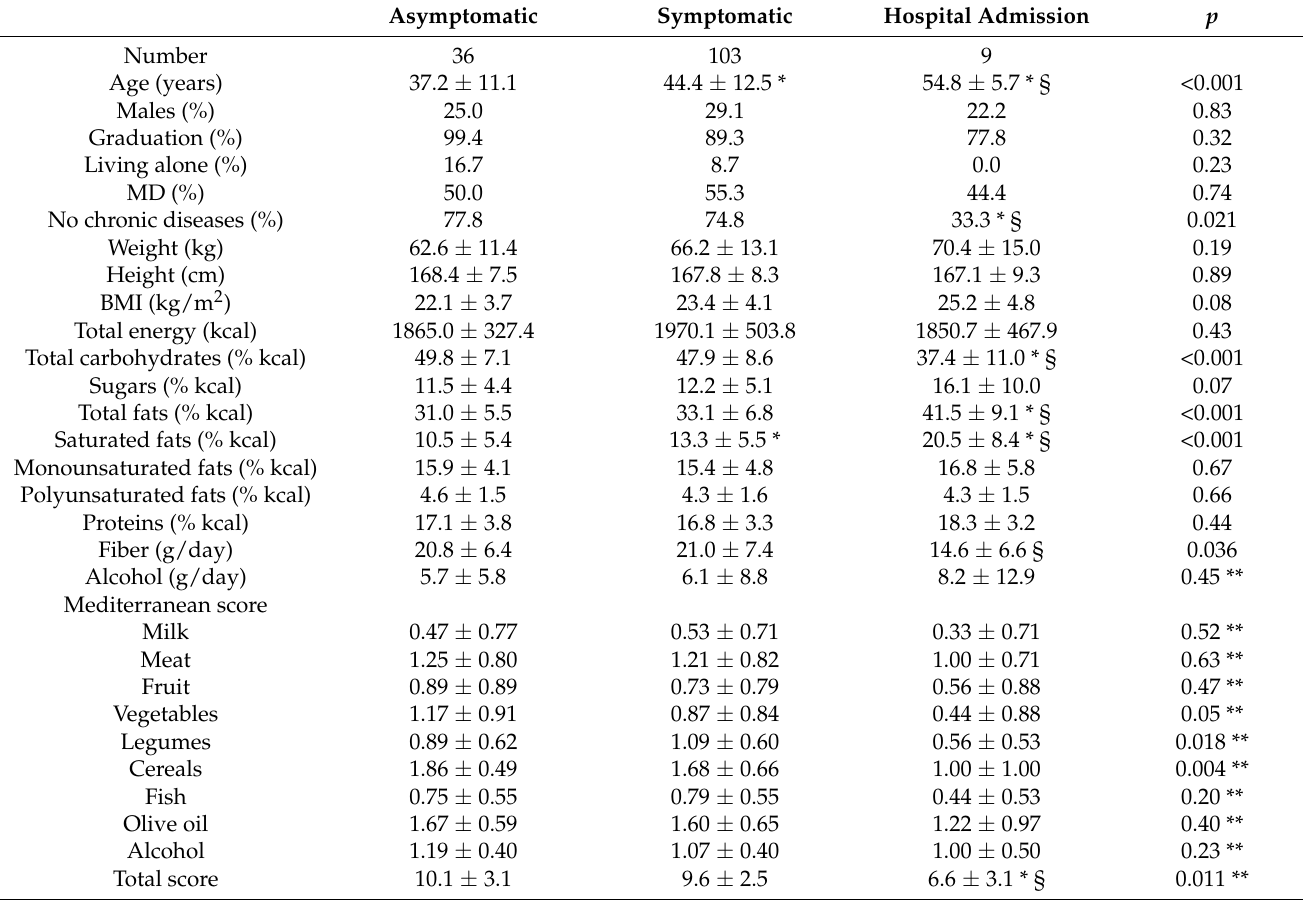
Table 3. Characteristics of the participants by the severity of the SARS-COV-2 infection. Asymptomatic Symptomatic Hospital